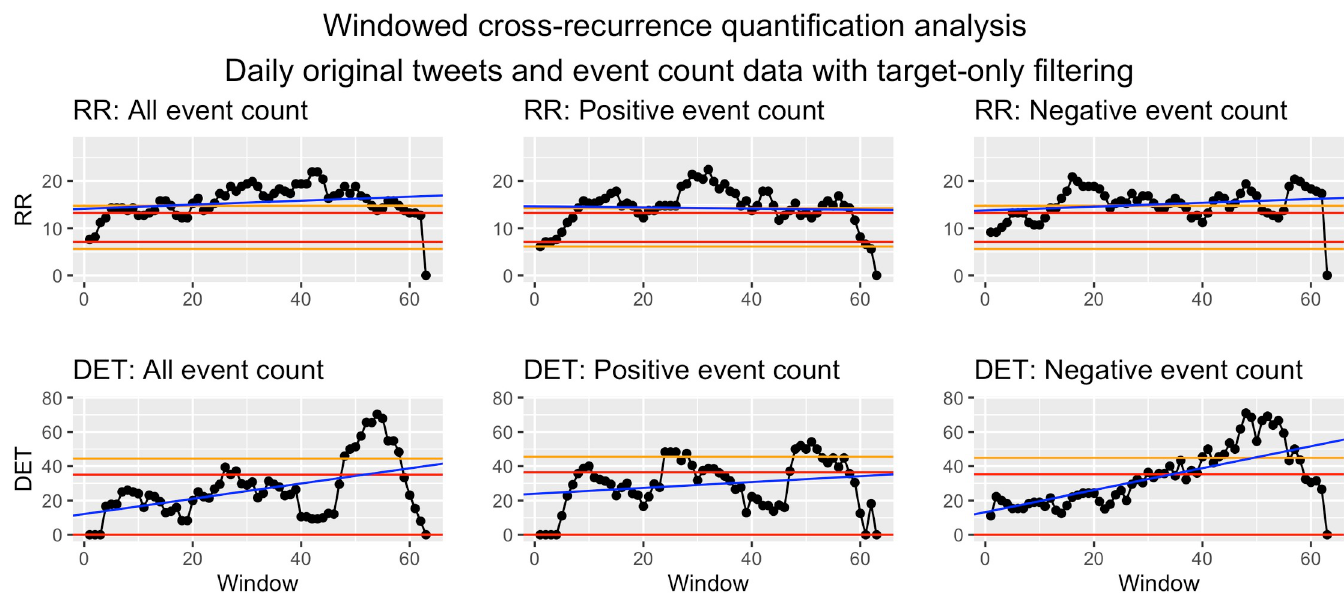
Fig 13. Windowed CRQA for daily original tweets and event counts from target filtered